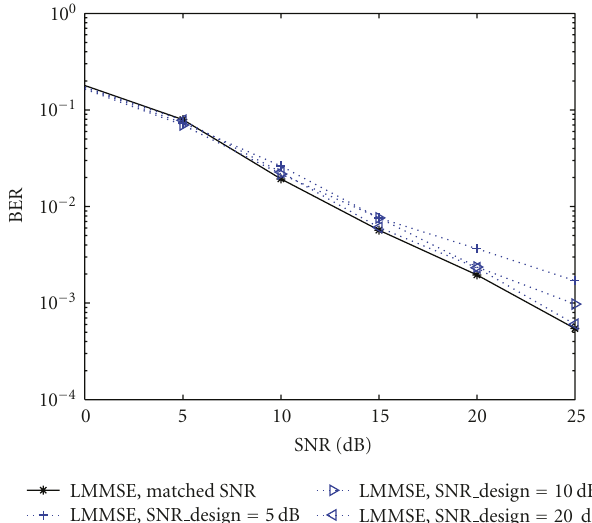
Figure 9: BER comparison between LMMSE channel estimation with matched SNR and LMMSE channel estimation with designed SNRs.